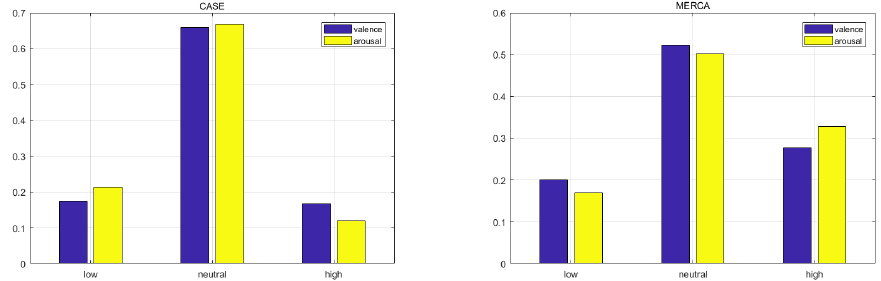
Figure 10. Sample percentage in each class of